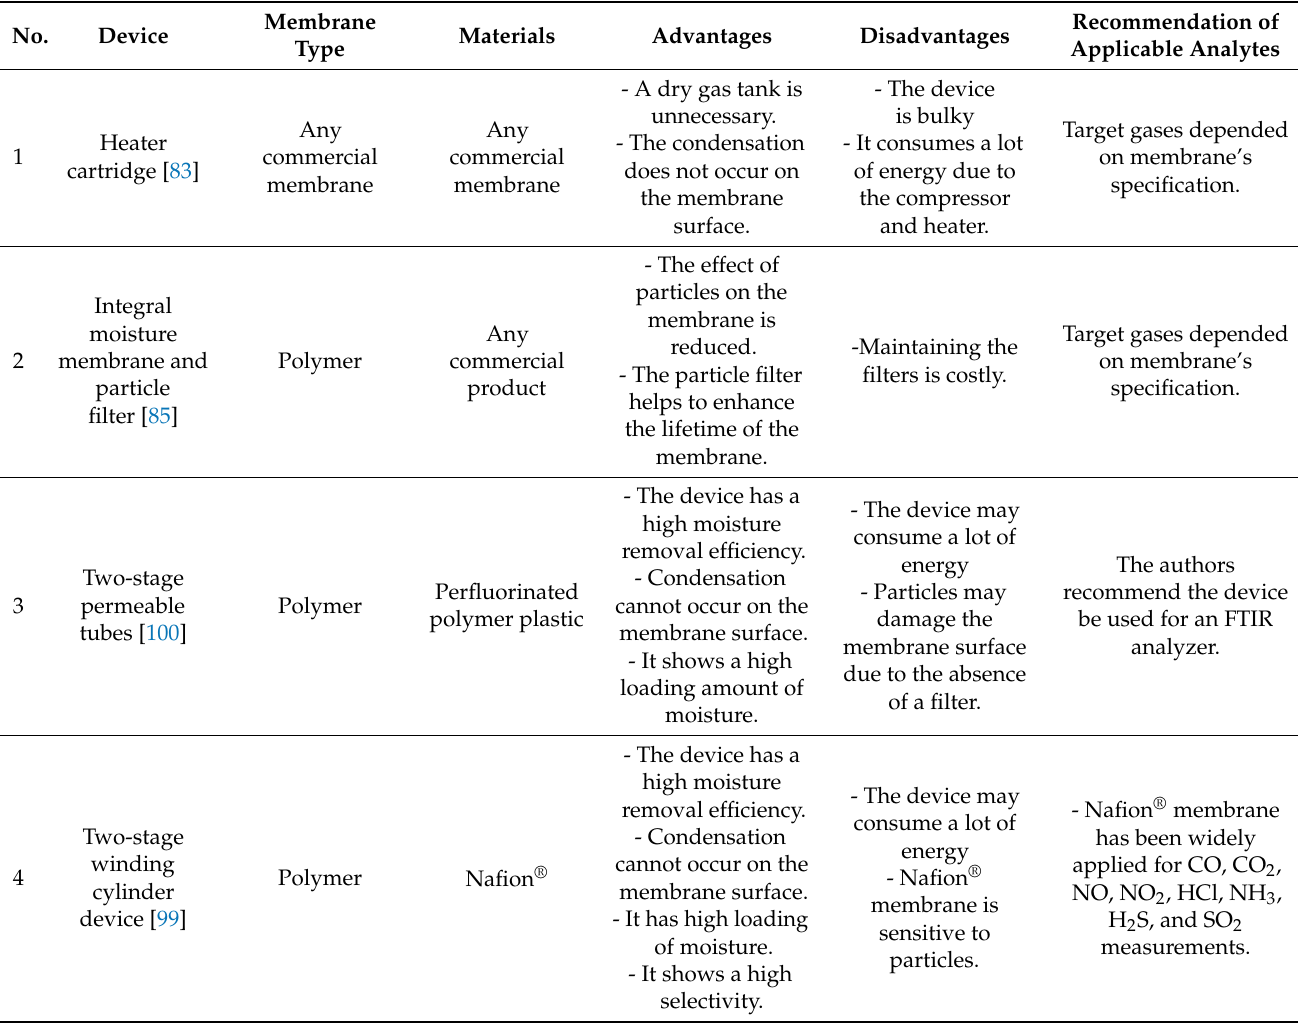
Table 3. Development of permeation devices to remove moisture in the flue